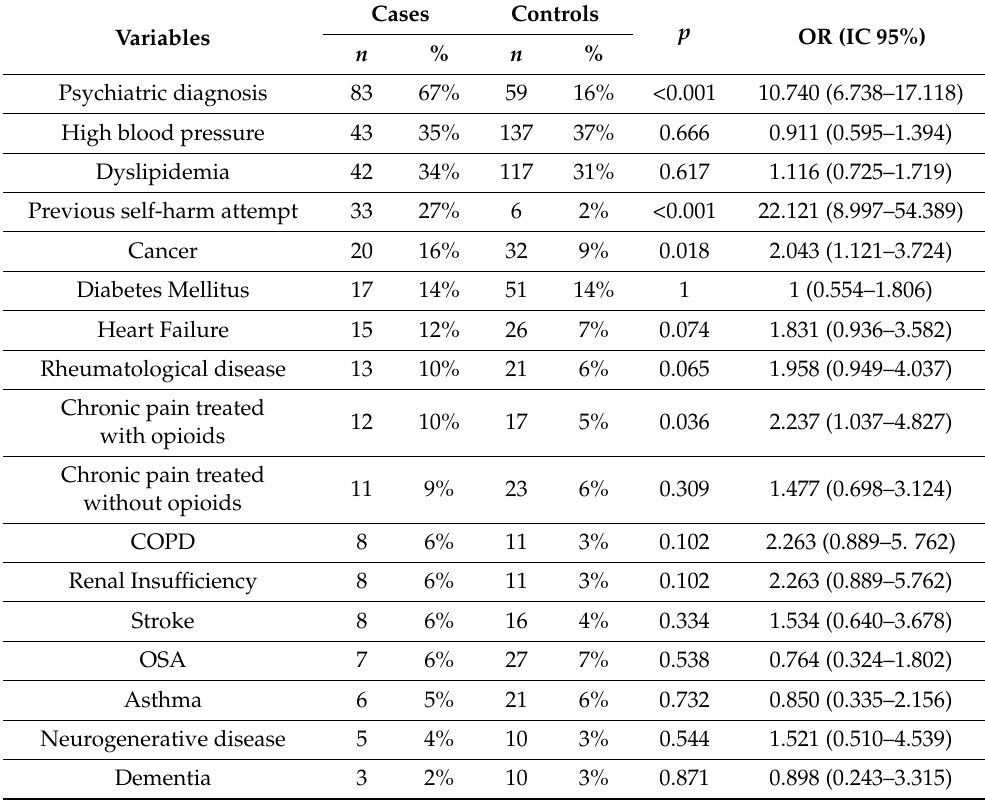
Table 2. Distribution of study variables and results of univariate analysis using Chi-square and Fisher’s